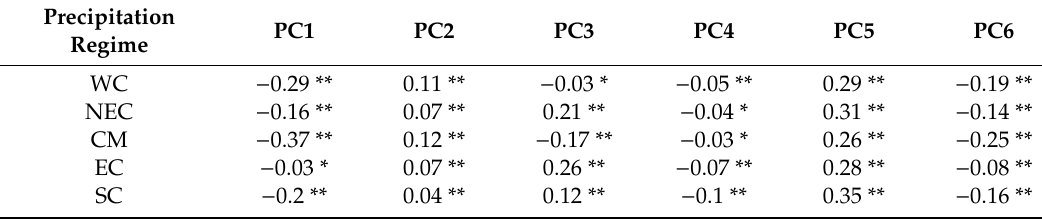
Table 3. Correlation coe ffi cients between time scores of principal component analysis (PCA) and precipitation measurements on a monthly